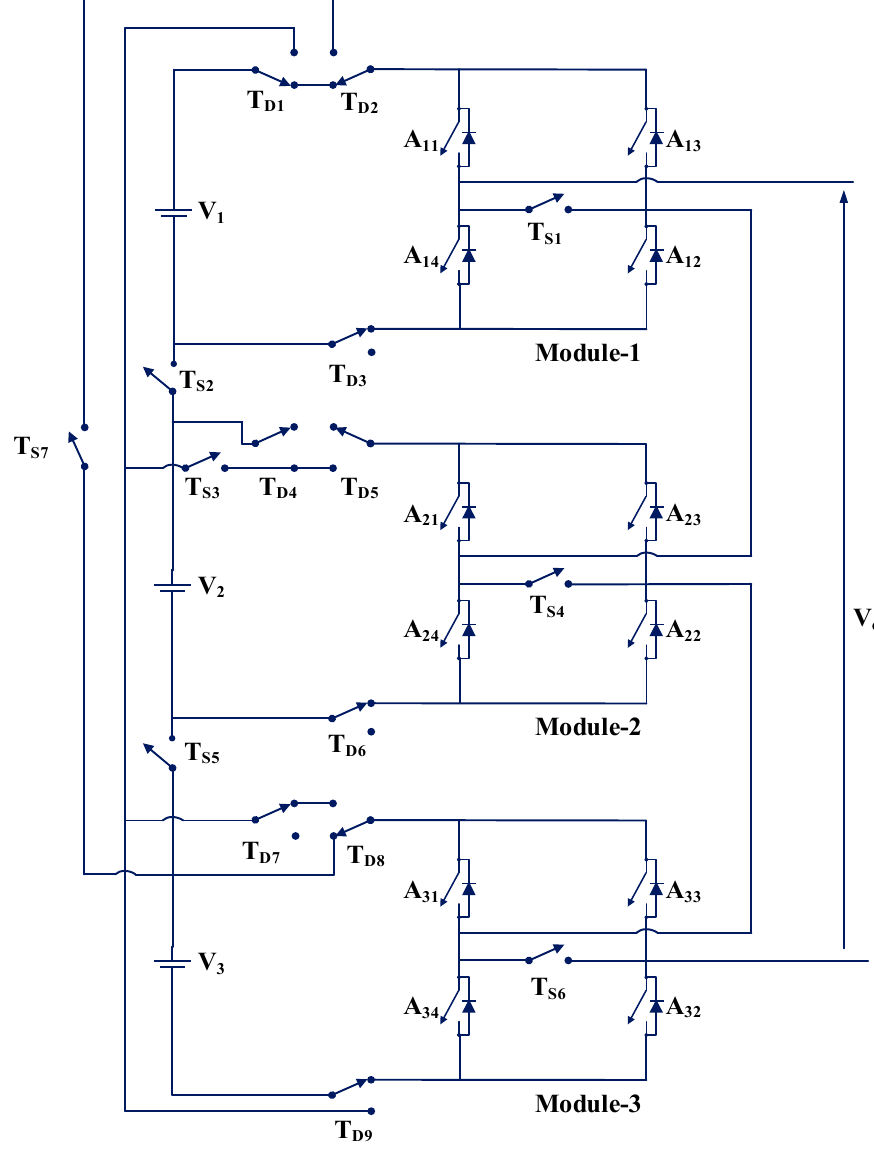
Figure 48. Single-phase seven-level FT MLI (TP53)